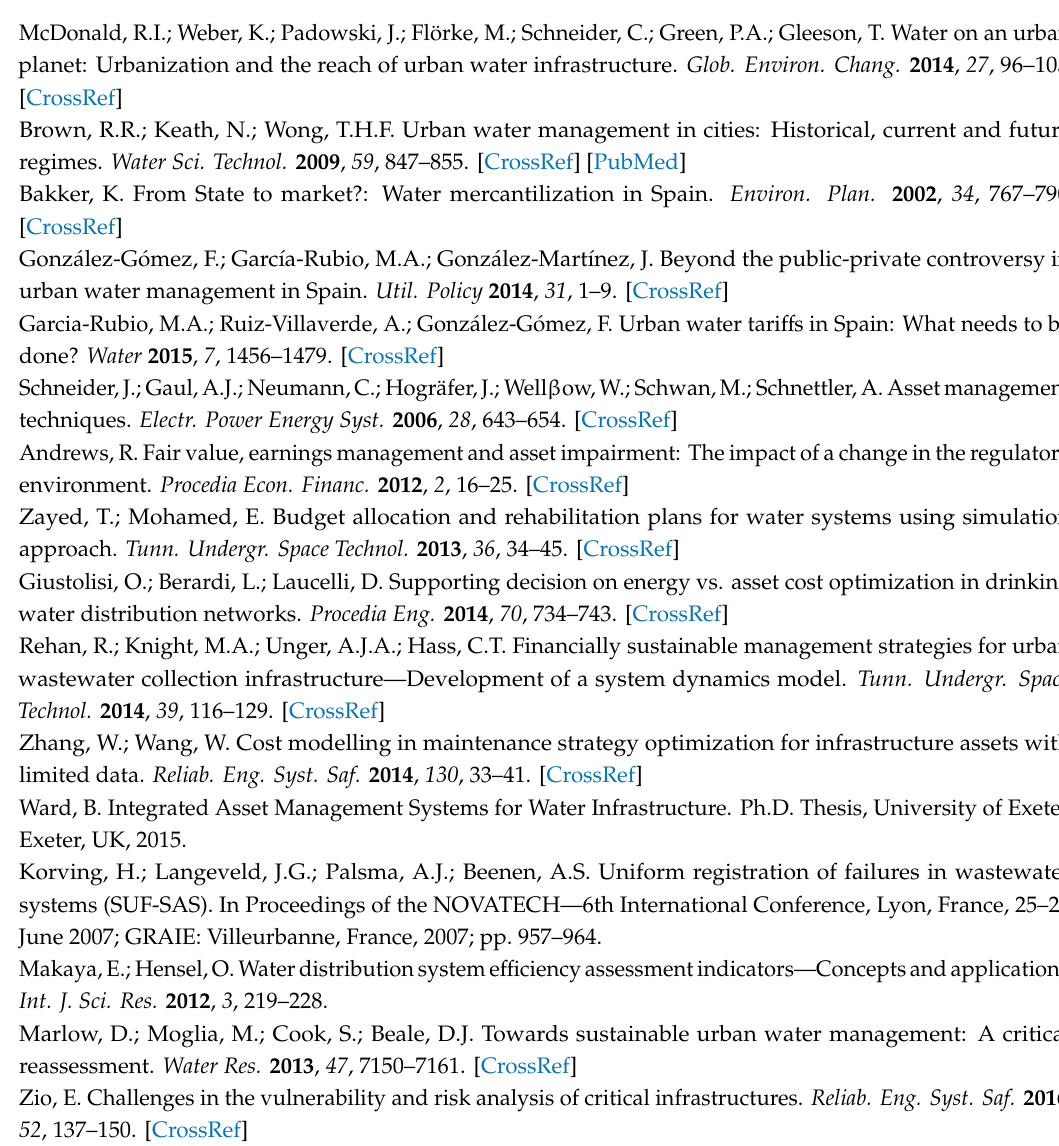
Table S1: Maintenance Investments 1985–2015; Figure S1. Main River Basin